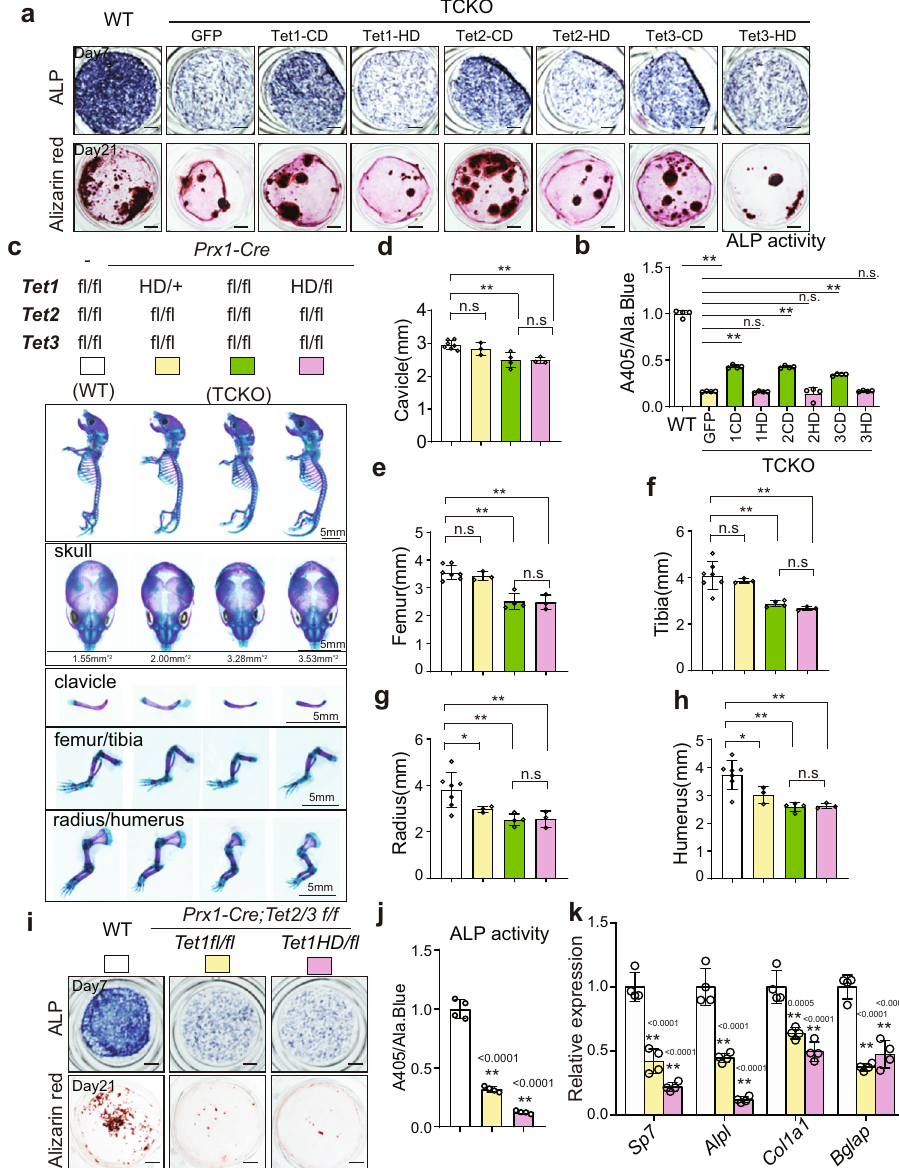
Fig. 3 | Tet-mediated bone formation is dependent on its catalytic domain. a ALPstaining and Alizarin red S staining after osteoblast differentiation for 7 days (up) and 21days (bottom),respectively. Cells wereisolatedfrom calvarialbonesof WT and TCKO mice, and cells from TCKO mice were infected with indicated len- tivirus. Scale bar=1mm. b ALP activity quanti fi cation was measured by phospha- tase substrate assay as A405/Ala. Blue. * P <0.05, ** P <0.01. Ordinary one-way ANOVA. Data are presented as mean±s.d., n =4 independent cell supernatants. c Thewholemountskeletonstaining ofWTandindicatedgenotypemicebyAlcian blue and Alizarin red S at P0. Scale bar=5mm. d – h Quanti fi cation of the length of clavicle ( d ), femur ( e ), tibia ( f ), radius ( g ), and humerus ( h ) of indicated genotype mice. * P <0.05, ** P <0.01. Two-tailed Student ’ s t test. Data are presented as